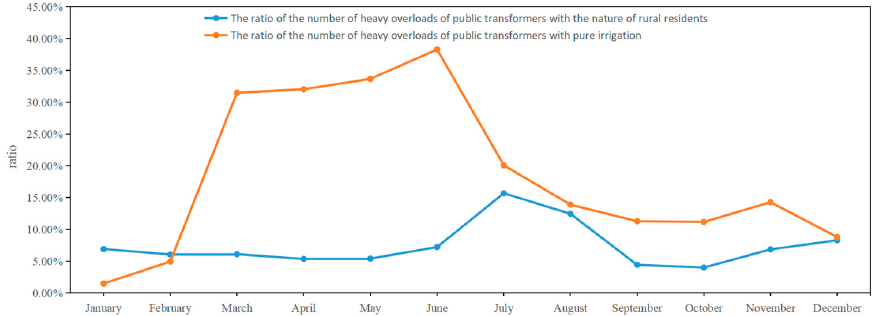
Figure 6. The ratio of the number of heavy overloads of public transformers in a region in different months.